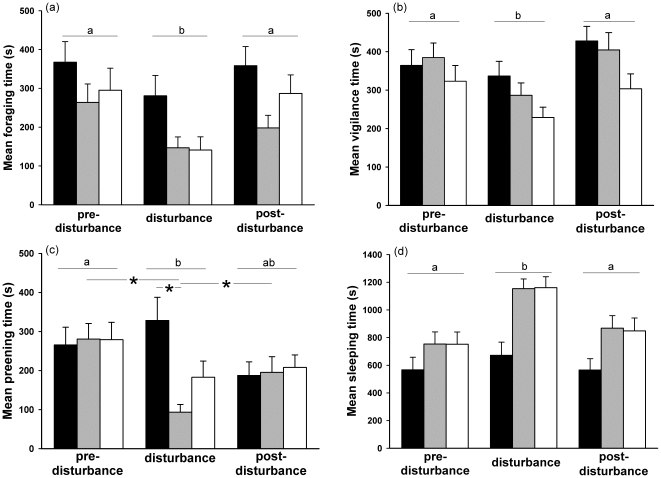
Time budget in mallards.(a) Foraging, (b) vigilance, (c) preening and (d) sleeping behaviours in the control group (black bar), group 1 (grey bar) and group 2 (white bar) for each observation week. Letters indicate significant differences between weeks. *Indicates significant differences between weeks for a group or between two groups.